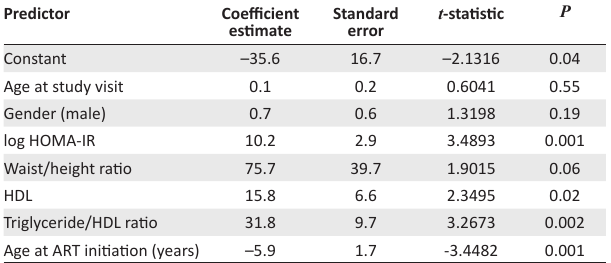
TABLE 3: Multivariable linear regression model with pulse-wave velocity z -score as the outcome variable, showing independent association with age at antiretroviral therapy initiation (Model 2).